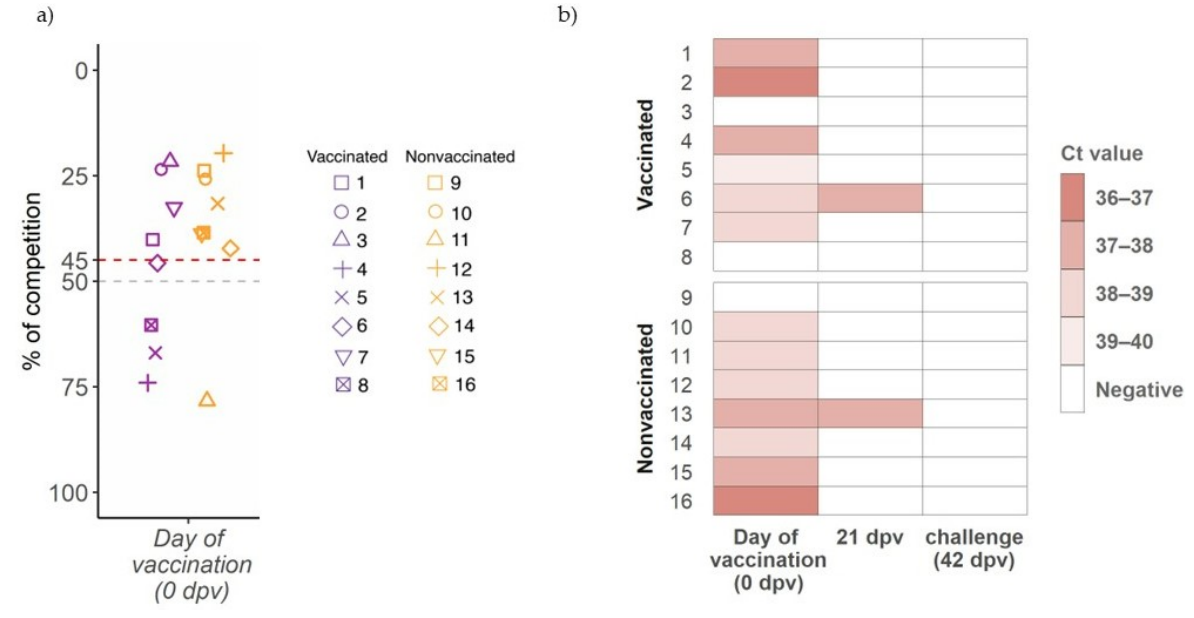
Figure 1. Detection of antibodies against influenza NP at day of first vaccination and SIV detection before challenge. ( a ) IgG antibody levels against NP detected by ELISA, where levels are shown on ordinate axis expressed as percentage of competition. Samples with a value greater than 45 (red line) are considered positive, below 50 (gray line) negative, and between both doubtful. Violet and orange boxplots and dots indicate samples from vaccinated and nonvaccinated groups. Each animal is represented by one sot shape. ( b ) SIV detection by RT-qPCR heatmap. Animal IDs are indicated in ordinate axis.